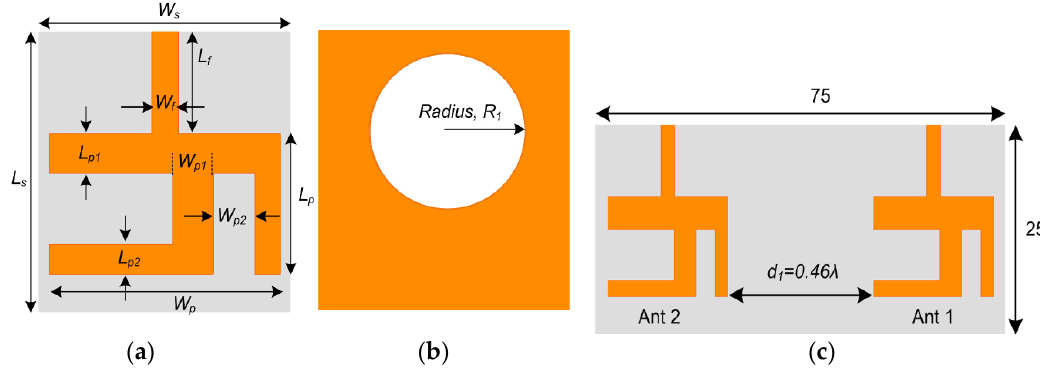
Figure 2. Geometry of LTE Antenna: ( a ) Single-Element, Front View; ( b ) Single-Element, Back View; ( c ) MIMO Configuration.